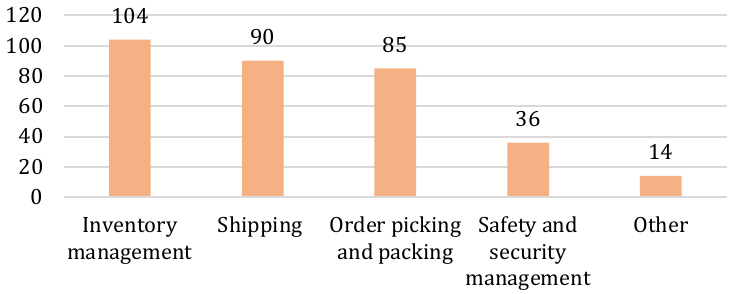
Figure 5: Composition of use of AI in the workplace